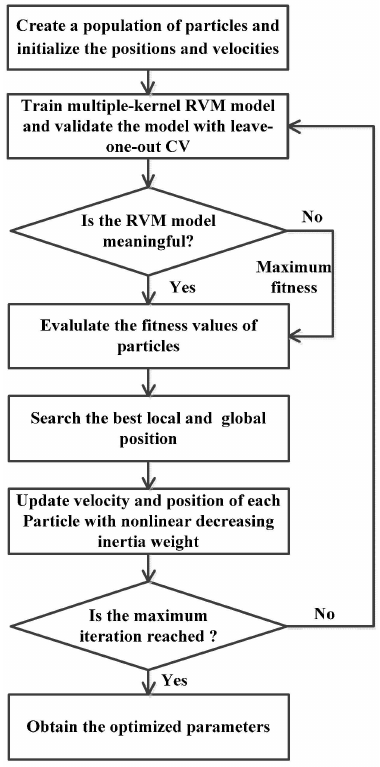
Figure 9. Process of optimizing the RVM parameters with